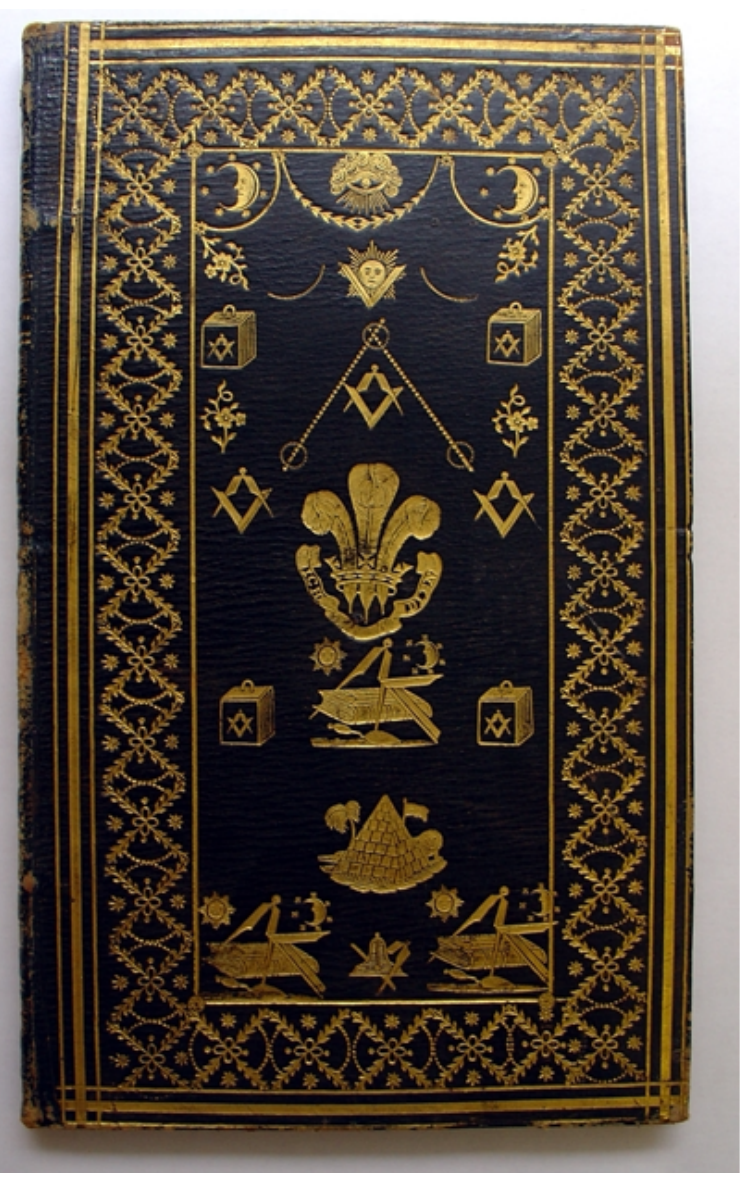
Fig. 41. Upper cover of the Freemasons’ Calendar 1808. Copyright and reproduced by permission of the Museum of Freemasonry, London. BE 142 UNI